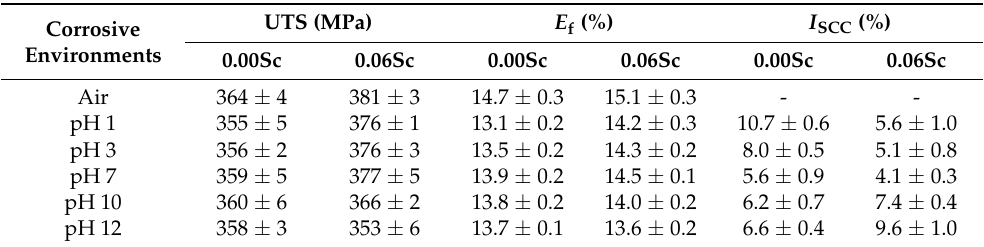
Figure 3. Stress-strain curves of two aged alloys at a strain rate of 5 × 10 − 6 s − 1 in different corrosive environments: ( a ) 0.00Sc; ( b ) 0.06Sc. Table 2. Slow strain rate test (SSRT) results of two aged alloys at a strain rate of 5 × 10 − 6 s − 1 in different corrosive